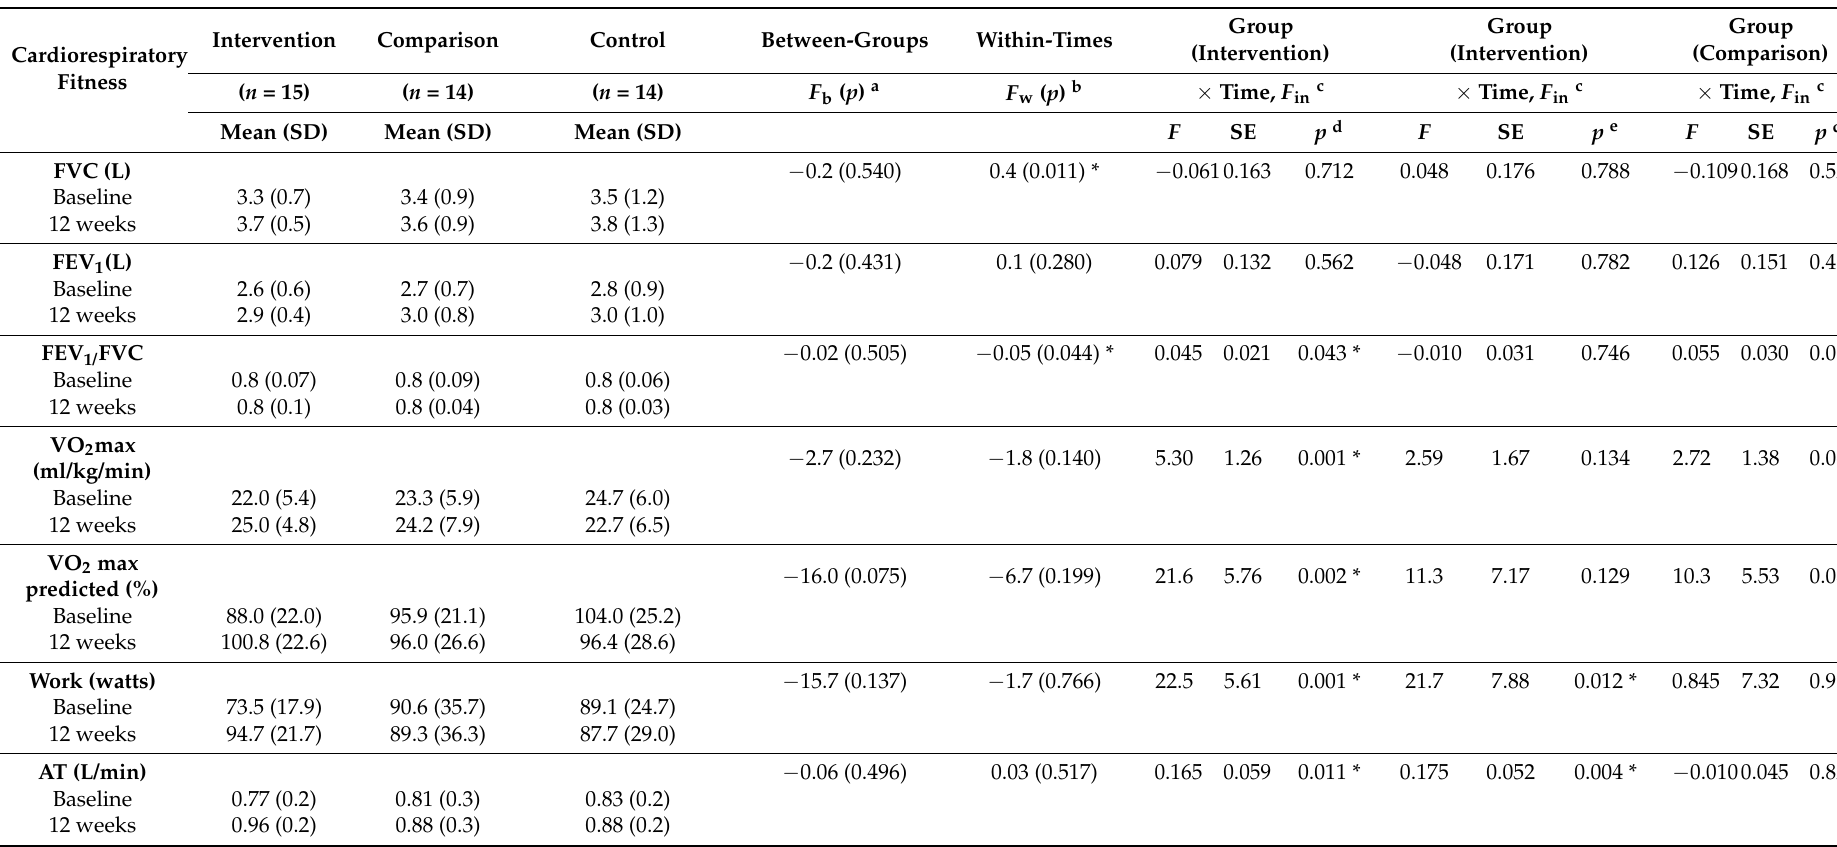
Table 5. The effectiveness of individualized aerobic exercise training combined with telephone-based motivational interviewing on cardiorespiratory fitness based on mixed model analysis.